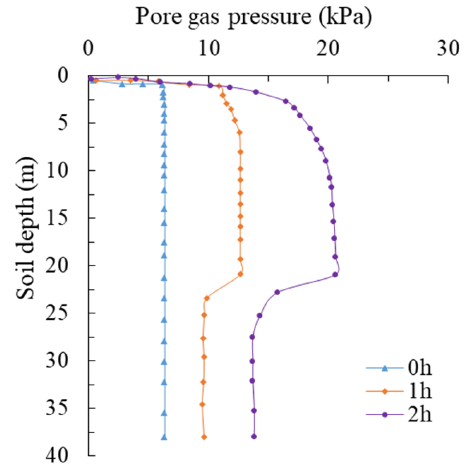
Figure 8. Pore gas pressure distribution in depth over time. Contour distribution pictures including pore gas pressure, pore water pressure, and water saturation of this slope at the initial status and at the time of 2 h are shown as Figures 9 and 10. The cloud picture of saturation is shown as Figure 11.